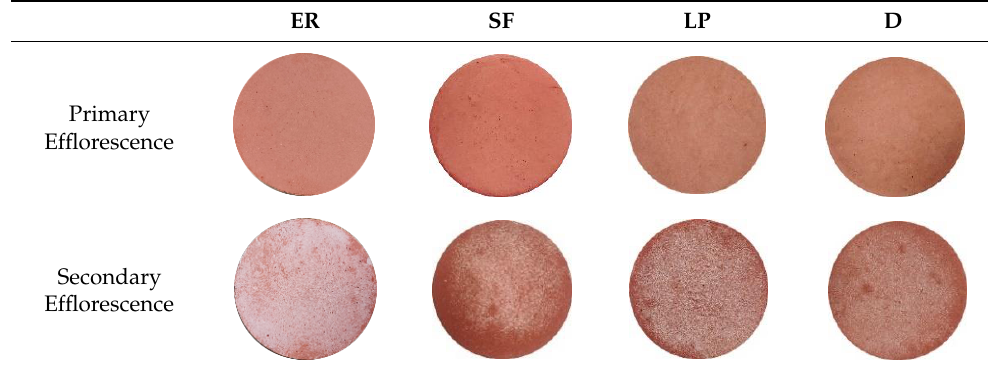
Table 3. Efflorescence of cement mortars.